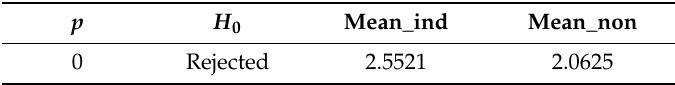
Table 6. Post-hoc for ANOVA. Mean_ind and mean_non denote the mean classes of the individualized HRTFs and the non-individualized ones,